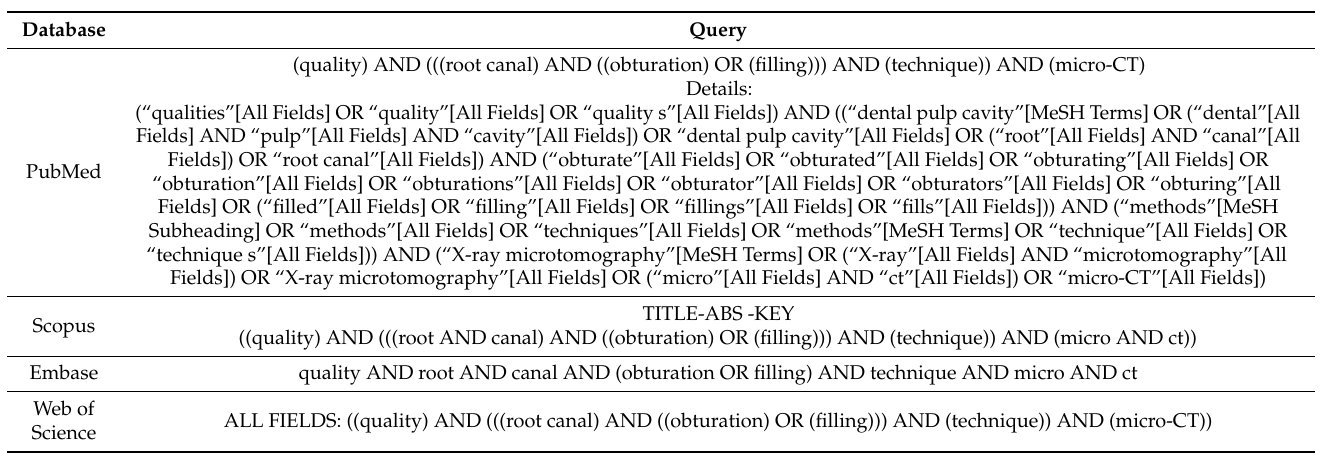
Table 1. Search queries used in the databases.